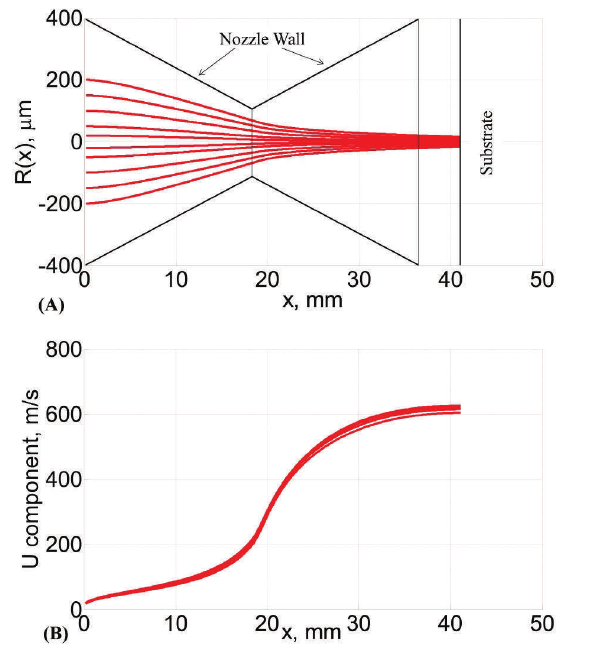
Figure 4. (A) Trajectory of silver particles with only Stokes drag force with Schiller-Naumann correction applied. (B) Axial velocity of the particles as they travel through the nozzle.